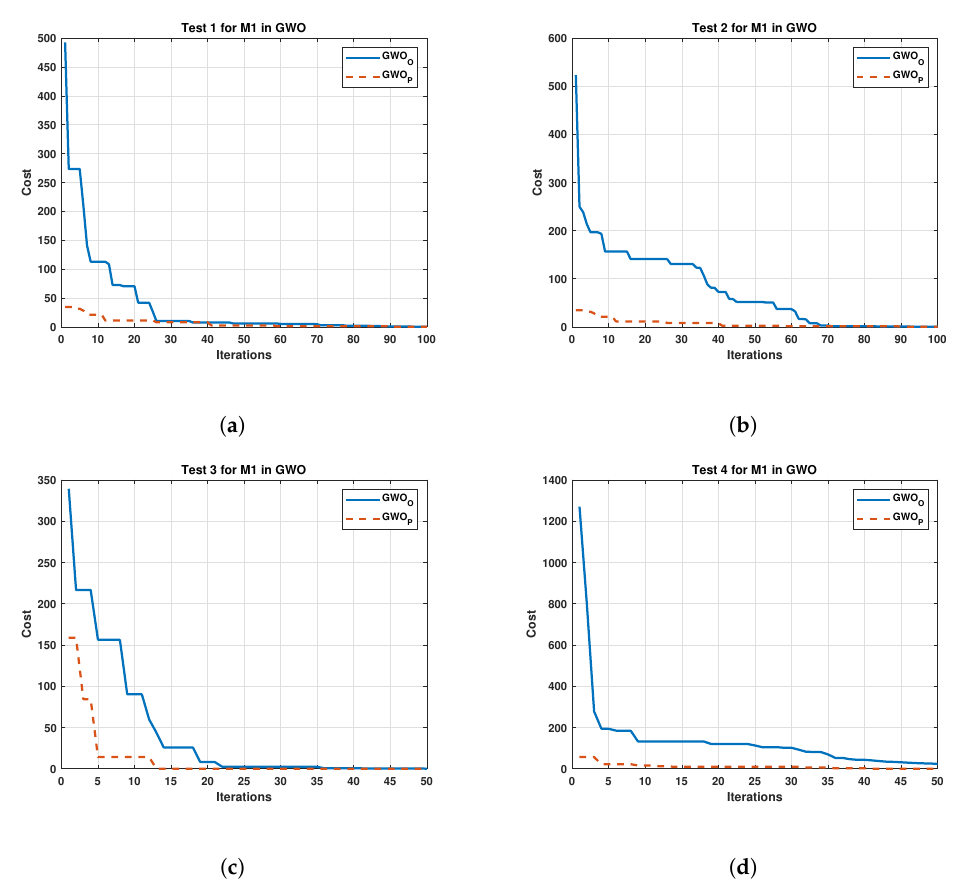
Figure 6. Comparison between the Original and the Gray Wolf Optimizer Proposed in four test for Motor 1. ( a ) cost and iterations of the GWO in test 1 for Motor 1; ( b ) cost and iterations of the GWO in test 2 for Motor 1; ( c ) cost and iterations of the GWO in test 3 for Motor 1; ( d ) cost and iterations of the GWO in test 4 for Motor